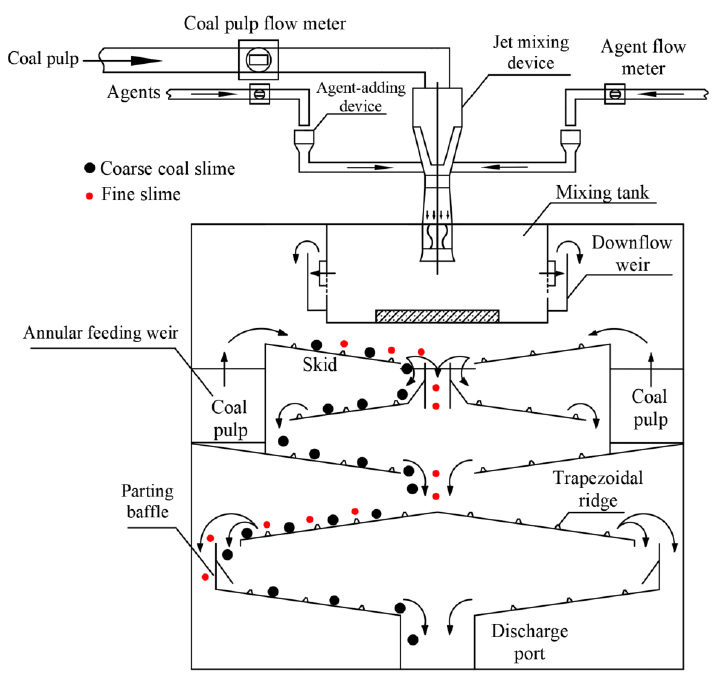
Figure 12. Schematic diagram of jet-graded mixing device.